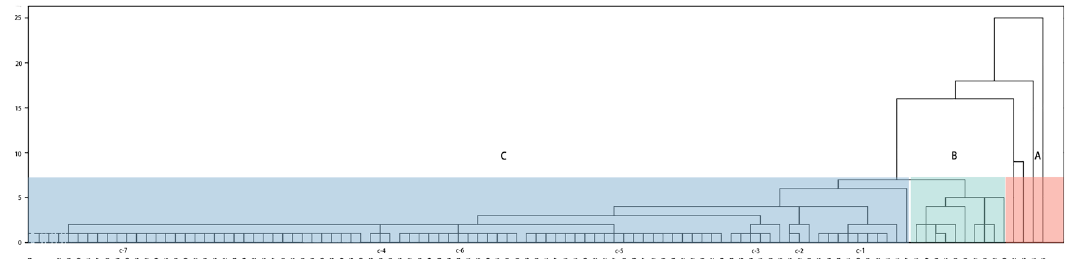
Figure 3: The cluster results are based on factor scores for each burial ( seven groups have too many members; to better display the results appropriately and save space, some members have been omitted from the fi gure; the completed results have been included in the supplementary materials ) .